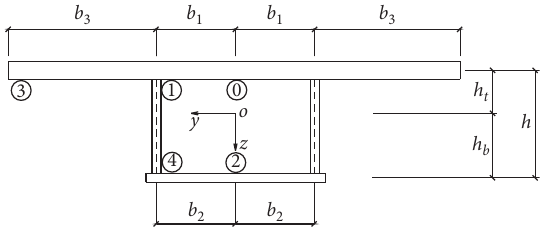
Figure 1: Sectional diagram of a composite box girder with